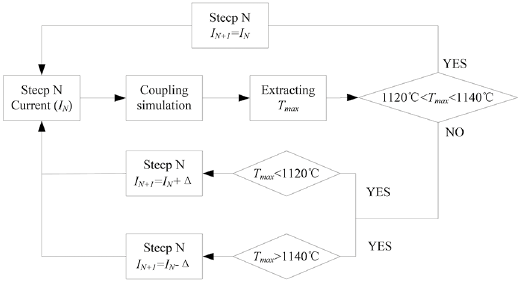
Figure 14: The algorithm of the current subroutine.